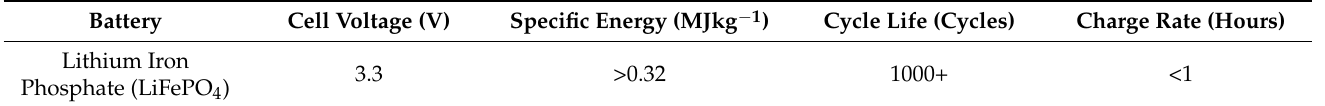
Table 1. Lithium Iron Phosphate battery